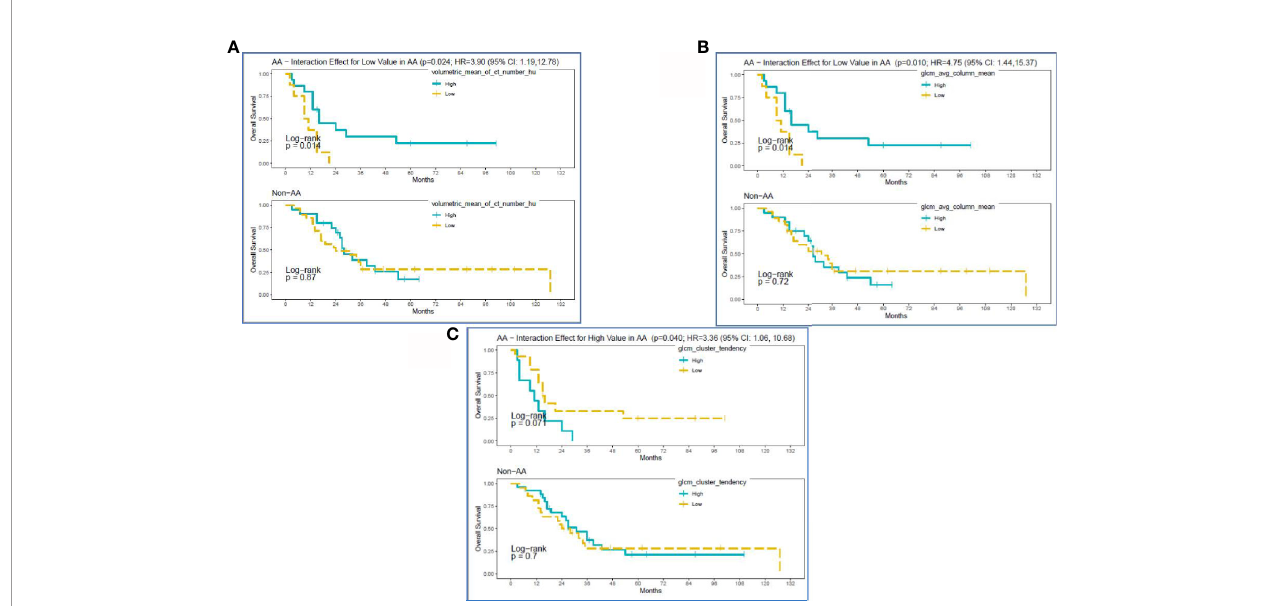
FIGURE 3 | Kaplan-Meier curves for signi fi cant interactions between radiomic features and overall survival among self-reported African American (AA) and Non-AA (Hispanic/ Latinx, H/L; and Non-Hispanic White, NHW) groups according to (A) Volumetric Mean CT (HU), (B) GLCM Avg Column Mean, and (C) GLCM Cluster